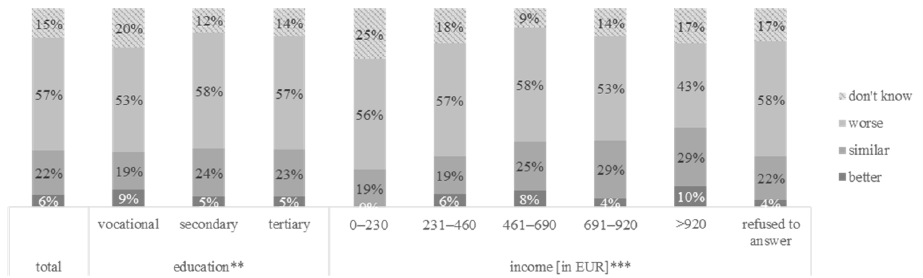
Figure 2. Expectations of future living standard as a pensioner, comparing to today’s old-age pensioners with similar tenure and occupation—by statistically significant cross-sections. Source: authors’ own elaboration, *** p < 0.01, ** p < 0.05, * p < 0.1.